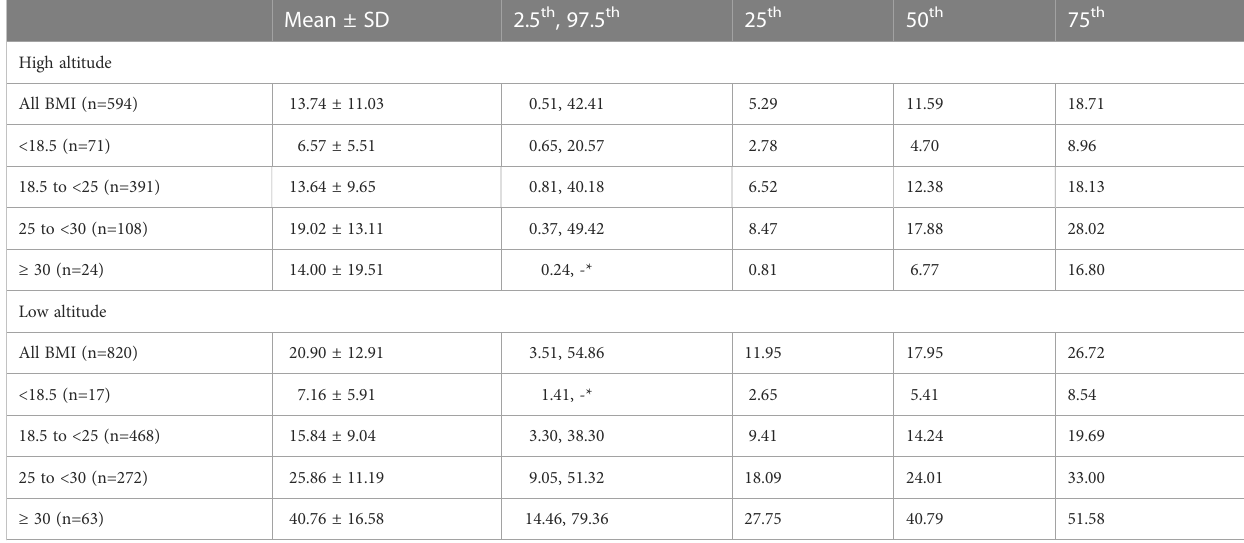
TABLE 4 Serum leptin concentrations (ng/ml) of native women living at high and low altitude by BMI subgroups (kg/m 2